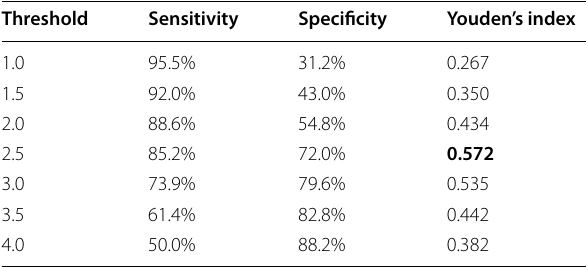
of sensitivity and specificity of